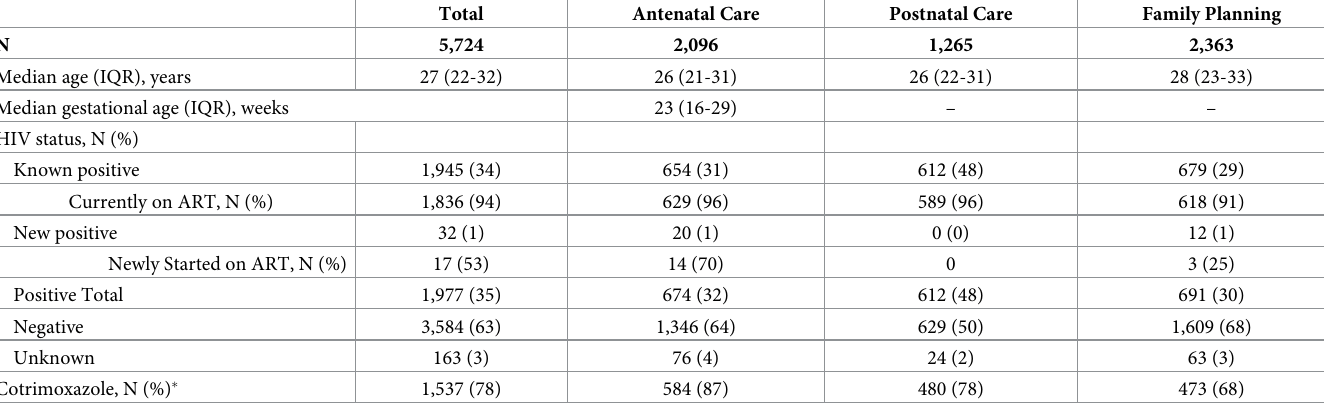
Table 1. Characteristics of women screened for TB while attending RMNCH services by point of care at four health facilities in Eswatini, 2017 (N = 5,724). Total Antenatal Care Postnatal Care Family